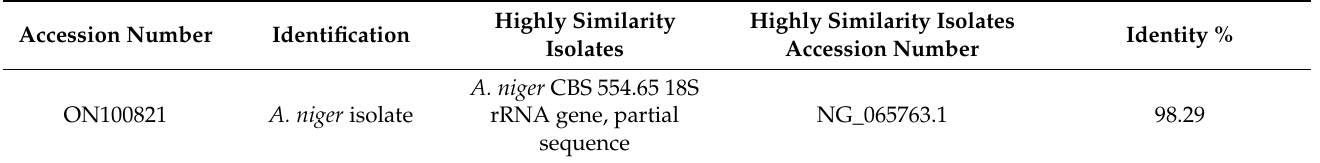
Table 1. Data of the molecular identification of A. niger endophytic fungus by 18S